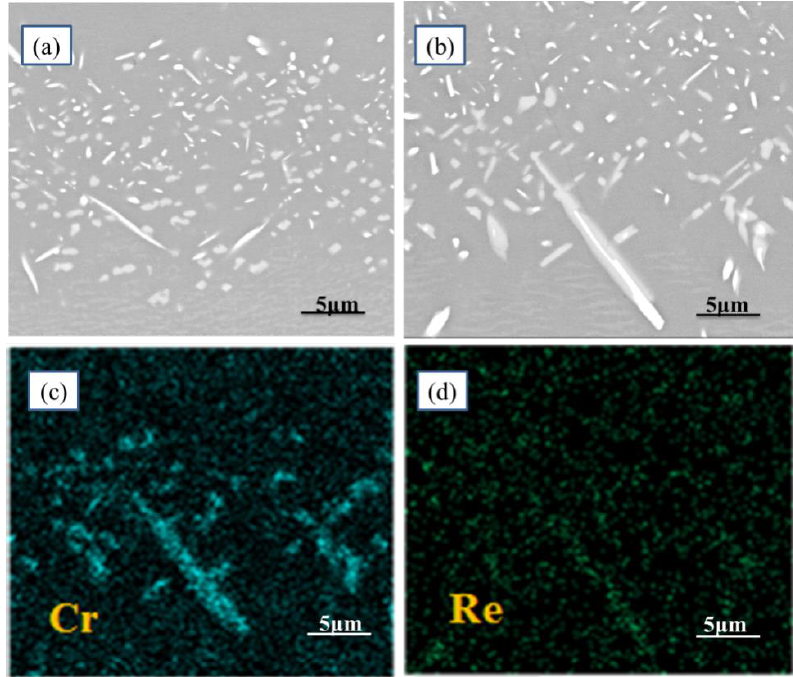
Figure 7. Cross-sectional BSE images and EDS element maps of precipitation phase: ( a ) 100 h, ( b ) 200 h, ( c ) EDS Cr distribution in Figure b , ( d ) EDS Re distribution in Figure ( b ).